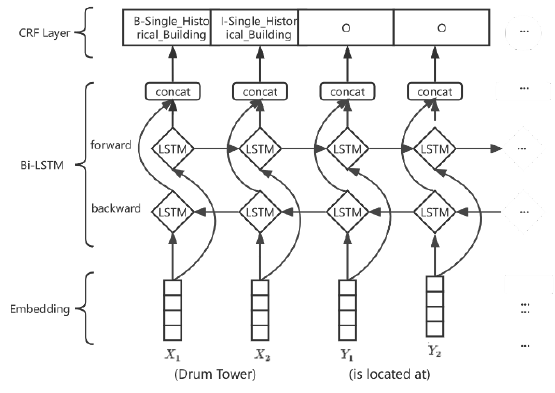
Figure 2 . The structure of BiLSTM-CRF network